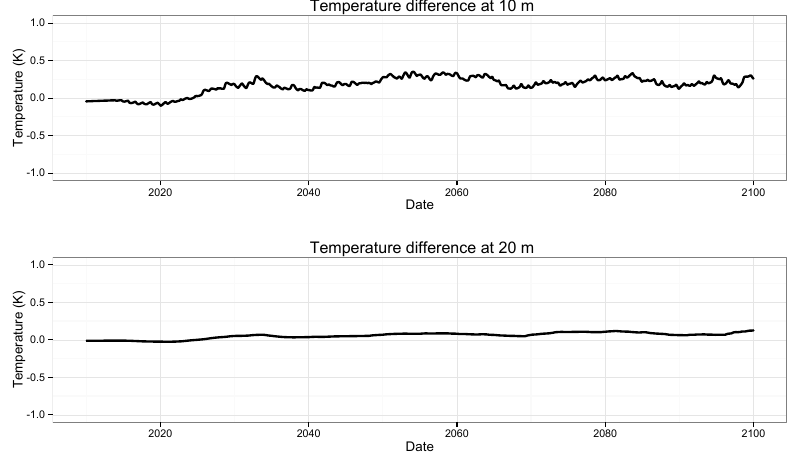
Figure 10. Difference in simulated 10m temperature for the long-term simulation between the reference run for SCH (Fig. 7) and the improved calibration of Fig. 9c and